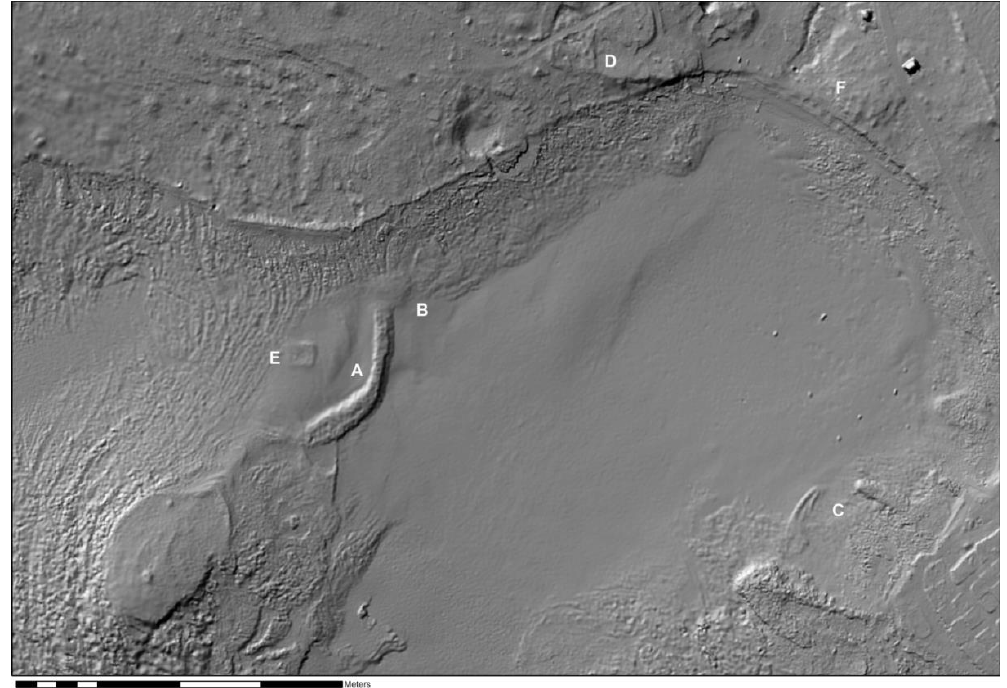
Figure 6. Shaded digital surface model generated from the filtered and strip-adjusted ALB-point cloud over the Roman harbour site of Kolone, Croatia.